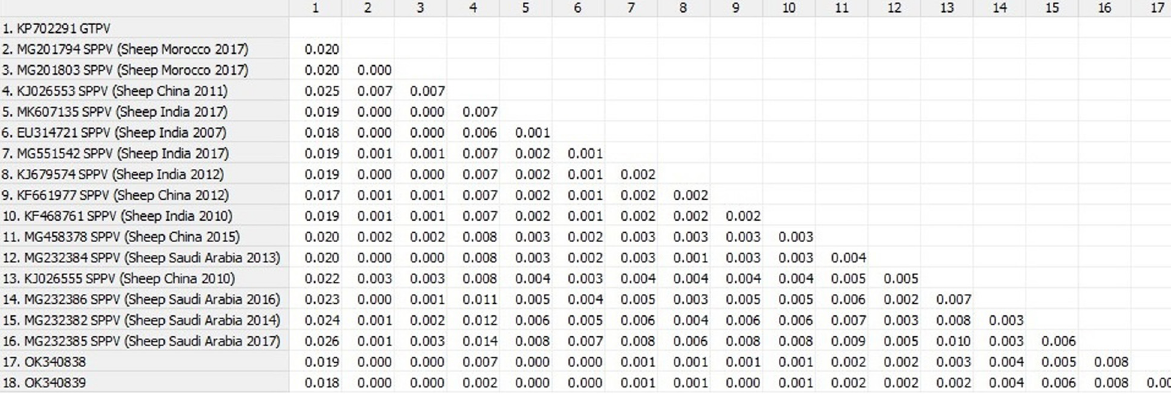
Figure 2: Estimates of evolutionary divergence between sequences and the number of base substitutions per site from between sequences are shown. Analyses were conducted using the Tamura 3 - parameter model. The analysis involved 18 nucleotide sequences ( 2 from the current study and 16 from Genbank ) . Evolutionary analyses were conducted in